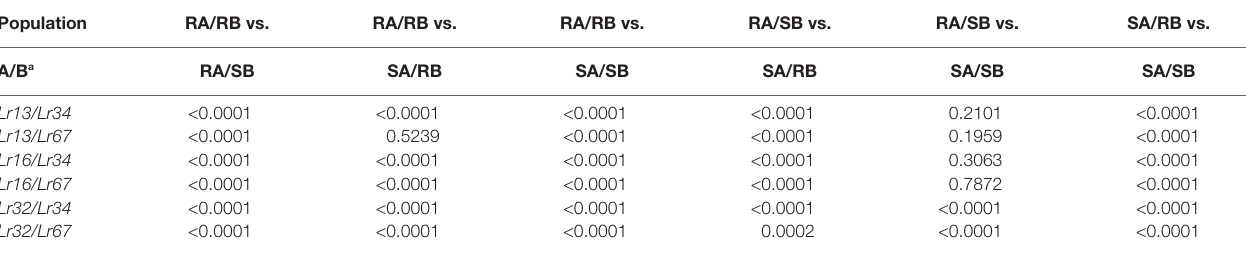
TABLE 2 | Significance of the difference between groups of lines with different combinations of resistance genes. Population RA/RB vs. RA/RB vs. RA/RB vs. RA/SB vs. RA/SB vs. SA/RB vs.